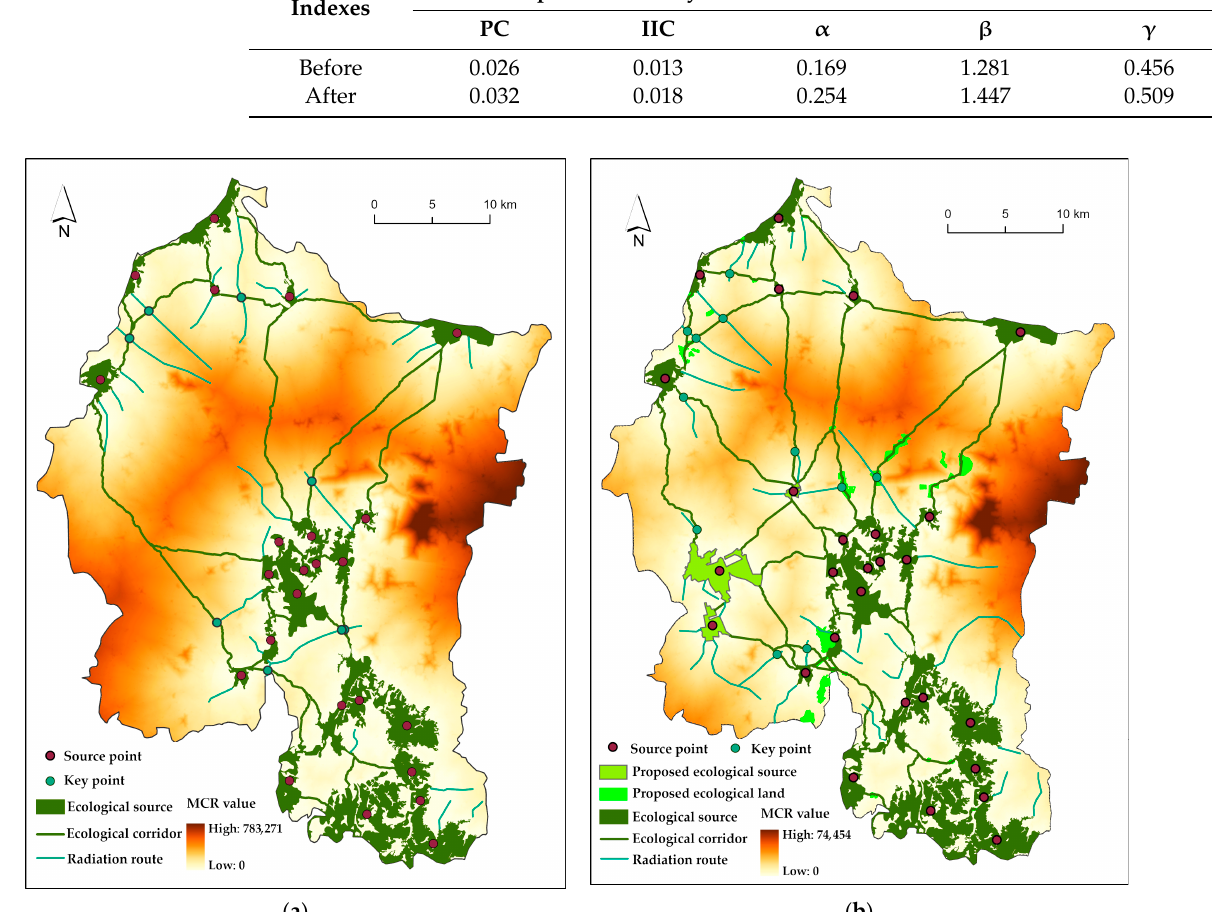
Figure 15. Network analysis of the ESP optimization. ( a ) ESP network before optimization; ( b ) ESP network after optimization. Table 9. Evaluation indexes before and after the ESP optimization.